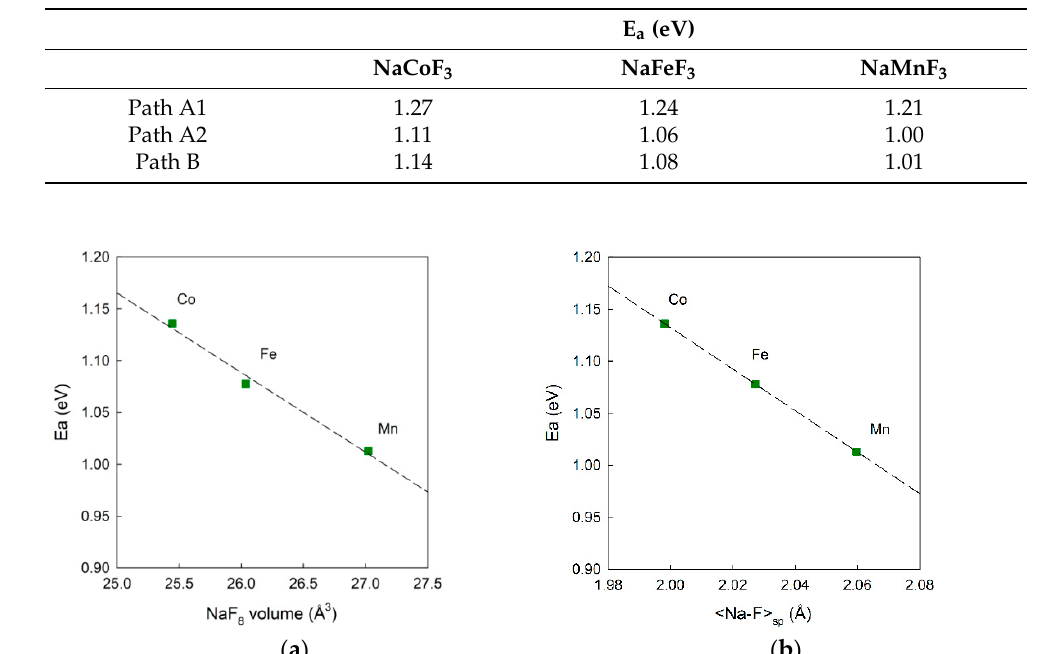
Figure 9. ( a ) Na-ion migration barrier (E a ) for path B as a function of the Na − F coordination poly- hedral volume for NaMF 3 (M = Co, Fe, and Mn); ( b ) Na-ion migration barrier (E a ) for path B as a function of the average Na − F distance at the saddle point configuration for NaMF 3 (M = Co, Fe, and Mn). E a was calculated, and volumes were experimentally derived values in this study. The dashed line is the linear interpolation of the data.